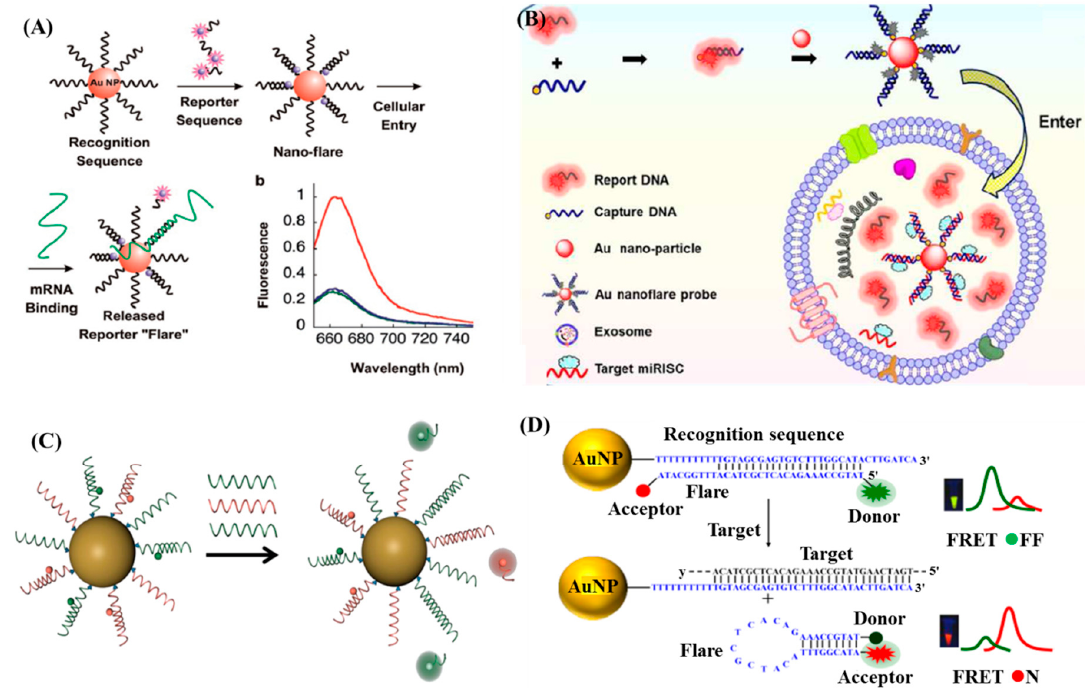
Figure 6. ( A ) Nanoflares probes for mRNA detection. Reproduced with permission from reference [105]. ( B ) The structure of Au nanoflare probe and its mechanism of detecting miR-1246 in exosomes. Reproduced with permission from reference [110]. ( C ) Schematic representation of target detection by multiplexed nanoflares. The multiplexed nanoflares bind different target nucleic acids (shown in red and green), displacing the corresponding flare. Reproduced with permission from reference [102]. ( D ) Design and working principle of the specific sequence responsive FRET nanoflares. Reproduced